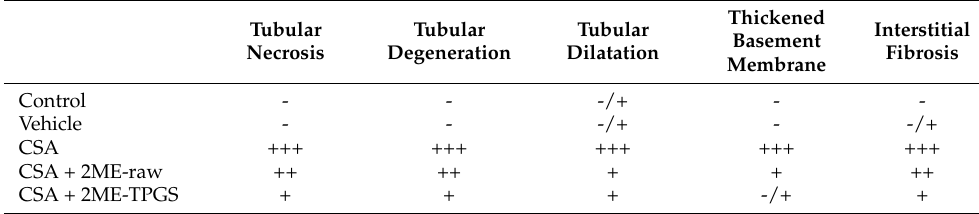
Figure 3. Effects of 2ME-TPGS on CSA-induced kidney injury as visualized using H&E, Masson’s Trichrome (MT), Picrosirius Red (PSR), and Periodic acid–Schiff (PAS) stains. In H&E-stained sections, black arrows indicate atrophy of glomerular capillary tuft and red arrows indicate extensive renal tubular damage. In MT-stained sections, blue coloration indicates collagen deposition. In PSR-stained sections, red coloration indicates collagen deposition. In PAS-stained sections, intense bluish-purple coloration indicates thickening of the glomerular basement membrane. Table 2. Semi-quantitative scoring of tubular injury and